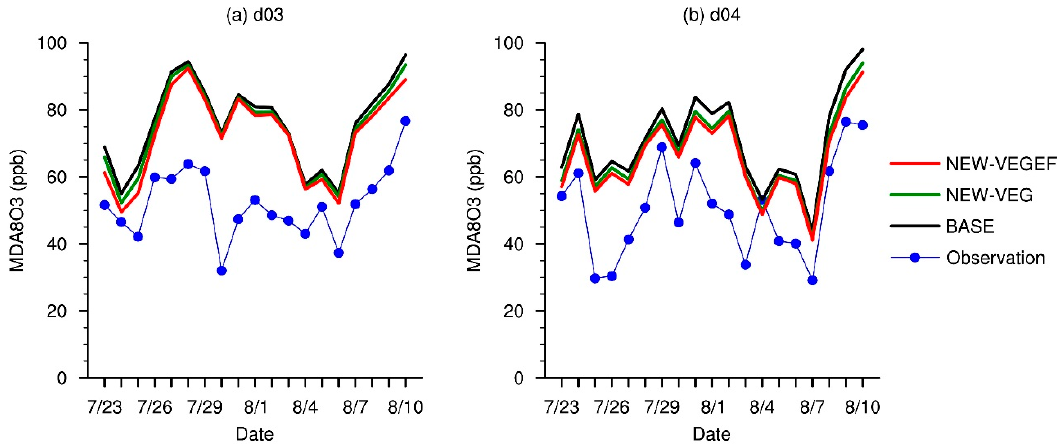
Figure 8. Time series comparisons of observed and simulated daily surface MDA8O3 in the BASE, NEW-VEG, and NEW-VEGEF cases during the target period in ( a ) d03 and ( b ) d04.